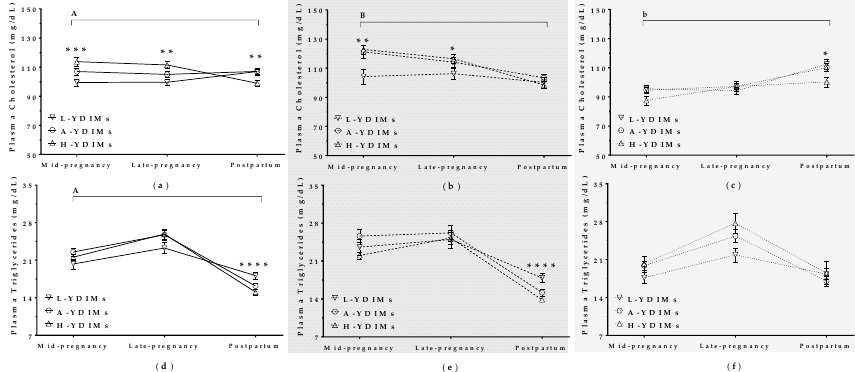
Figure 7. Plasma cholesterol in ( a ) all ewes, ( b ) mature ewes, and ( c ) maiden sheep showing high, average, or low milk yield at different stages of pregnancy and the postpartum period. Triglycerides in ( d ) all ewes, ( e ) mature ewes, and ( f ) maiden sheep showing high, average, or low milk yield at different stages of pregnancy and the postpartum period. L-YDIMs: low-yielding sheep with a YDIMs (daily milk yield during the first 6 months after lambing) of 1.17 L/d in average; A- YDIMs: average yielding sheep with a YDIMs of 1.90 L/d in average; H-YDIMs: high yielding sheep with a YDIMs of 2.70 L/d in average. Data are mean ± SEM. Significant interactions between pregnancy/postpartum stage and YDIMs are represented by an upper horizontal line (A: p < 0.0001; B: p < 0.001; and b: p < 0.06). Asterisks indicate significant differences between groups at each time point (**** p < 0.0001; *** p < 0.001; ** p <0.01; * p < 0.05).